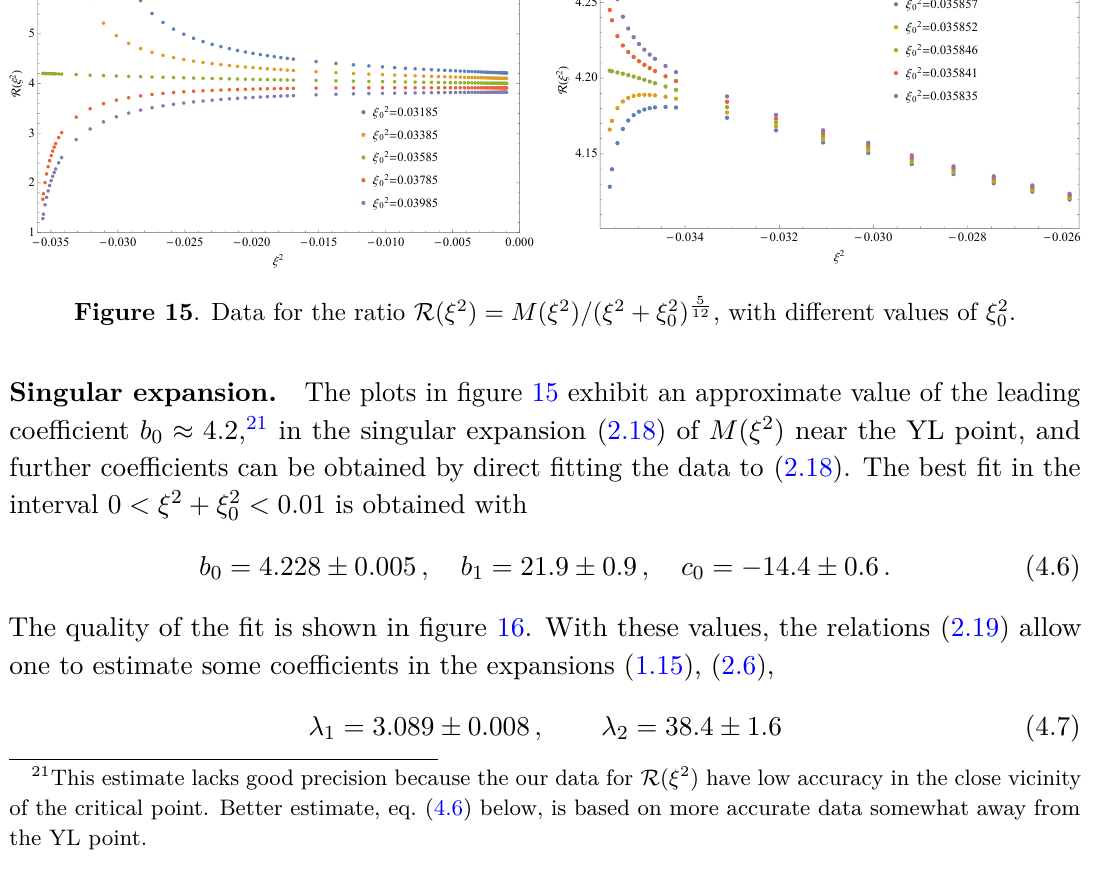
Figure 14 . Plots of M ( ξ 2 ) by fitting TFFSA data for ξ 2 > − ξ 2 by blue and red dots respectively. The purple line is given by mass dispersion relation (see section 5).